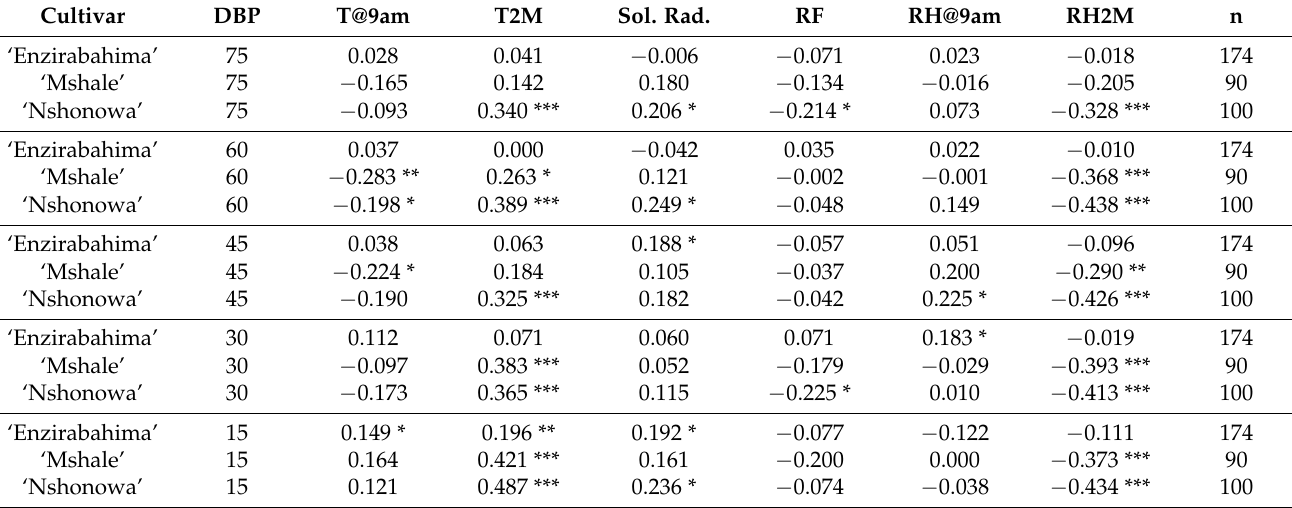
Table 3. Correlation coefficients of weather attributes with seed set in East African Highland Cooking bananas between 75 and 15 days before pollination.